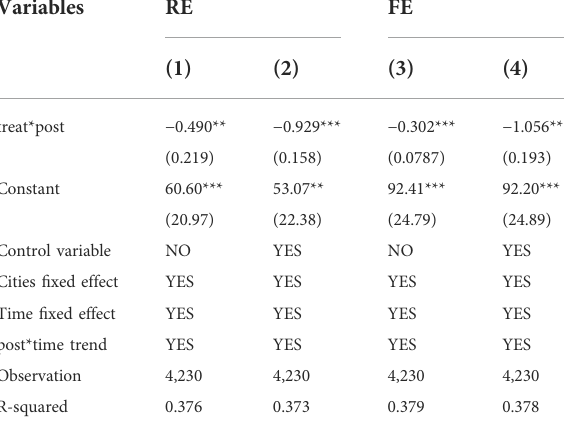
TABLE 6 PSM-DID test.